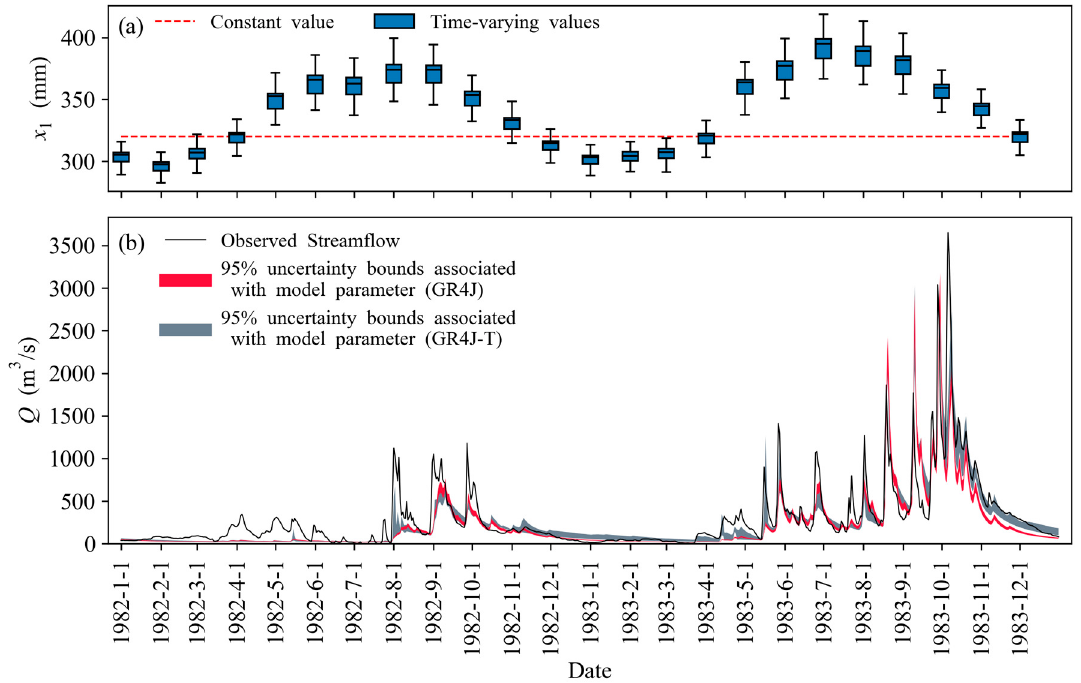
Figure 6. Temporal comparison of ( a ) the values of the parameter x 1 and ( b ) the simulated daily streamflow of the GR4J model and the GR4J-T model for Weihe Basin during SP1 (only the period from 1 January 1982 to 31 December 1983 are presented here). The uncertainty bounds associated with model parameter are derived from the streamflow simulation results using the corresponding 5000 parameter sets.